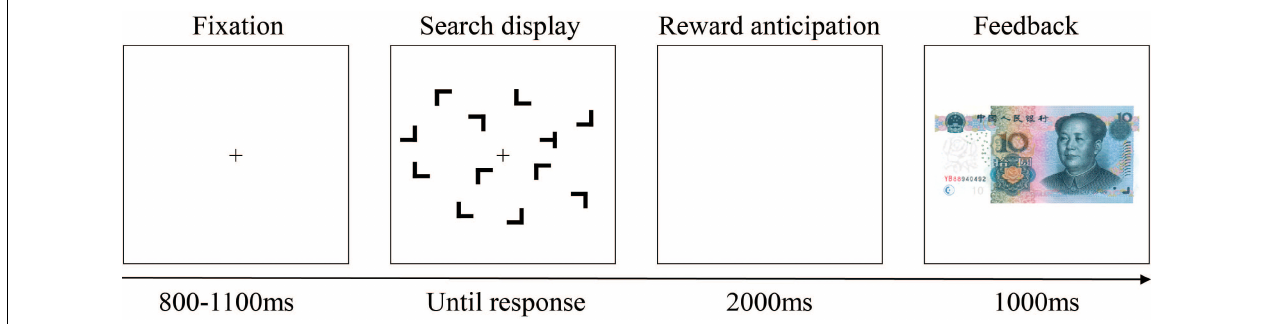
FIGURE 4 | Schematic representation of a single trial. After the fixation, a search display was presented. After participants’ searching and pressing the keyboard, a blank of 2,000 ms arose, followed by the feedback suggesting that whether there was a reward (with a paper money image) or not (without image; i.e., there was a blank screen) in this trial. For this trial, there was a